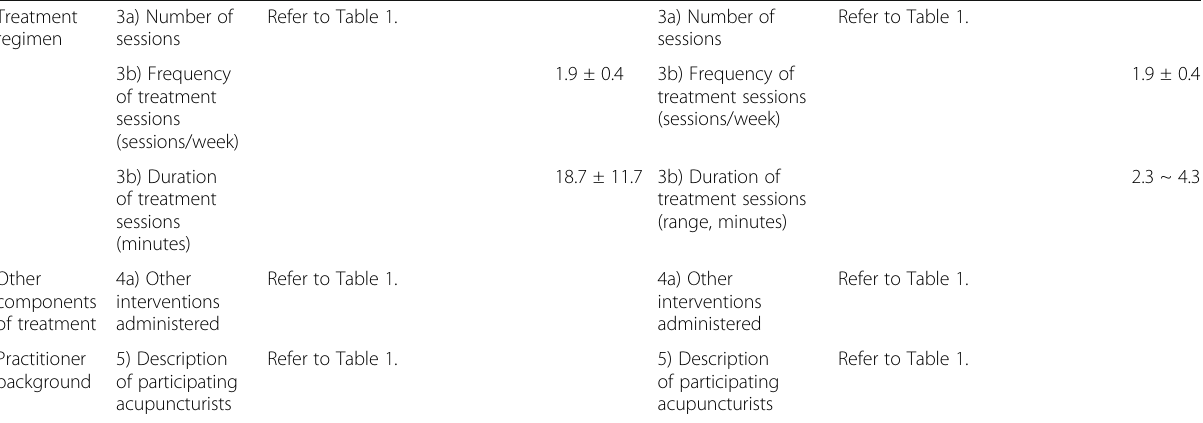
Table 7 Acupuncture and pharmacopuncture treatment used for LSS: data compiled and structured according to STRICTA standards (Continued) Treatment